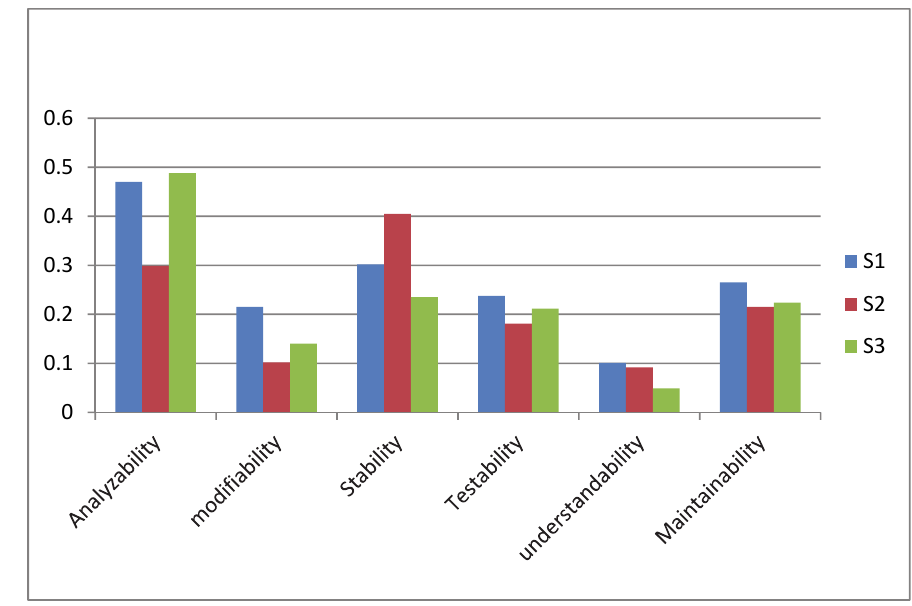
Fig. 9. Visualization of software